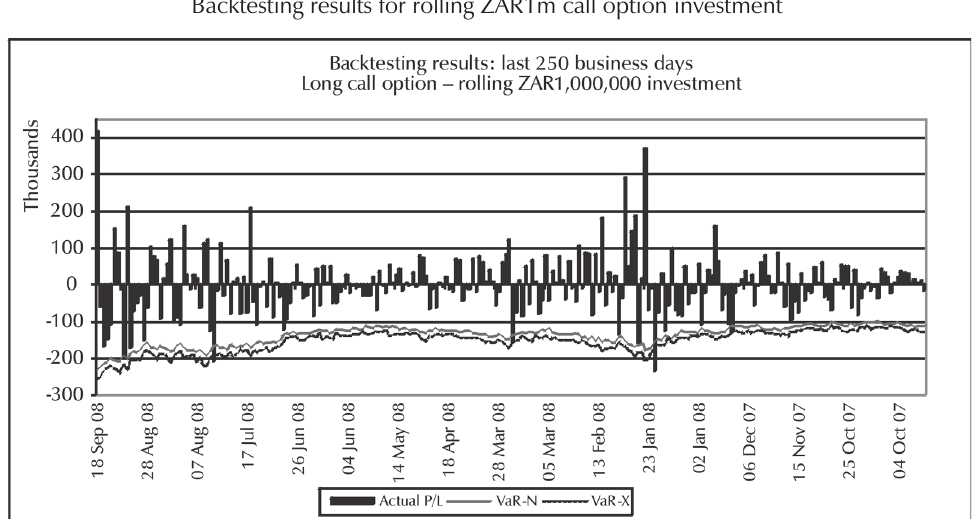
Backtesting results for rolling ZAR1m call option